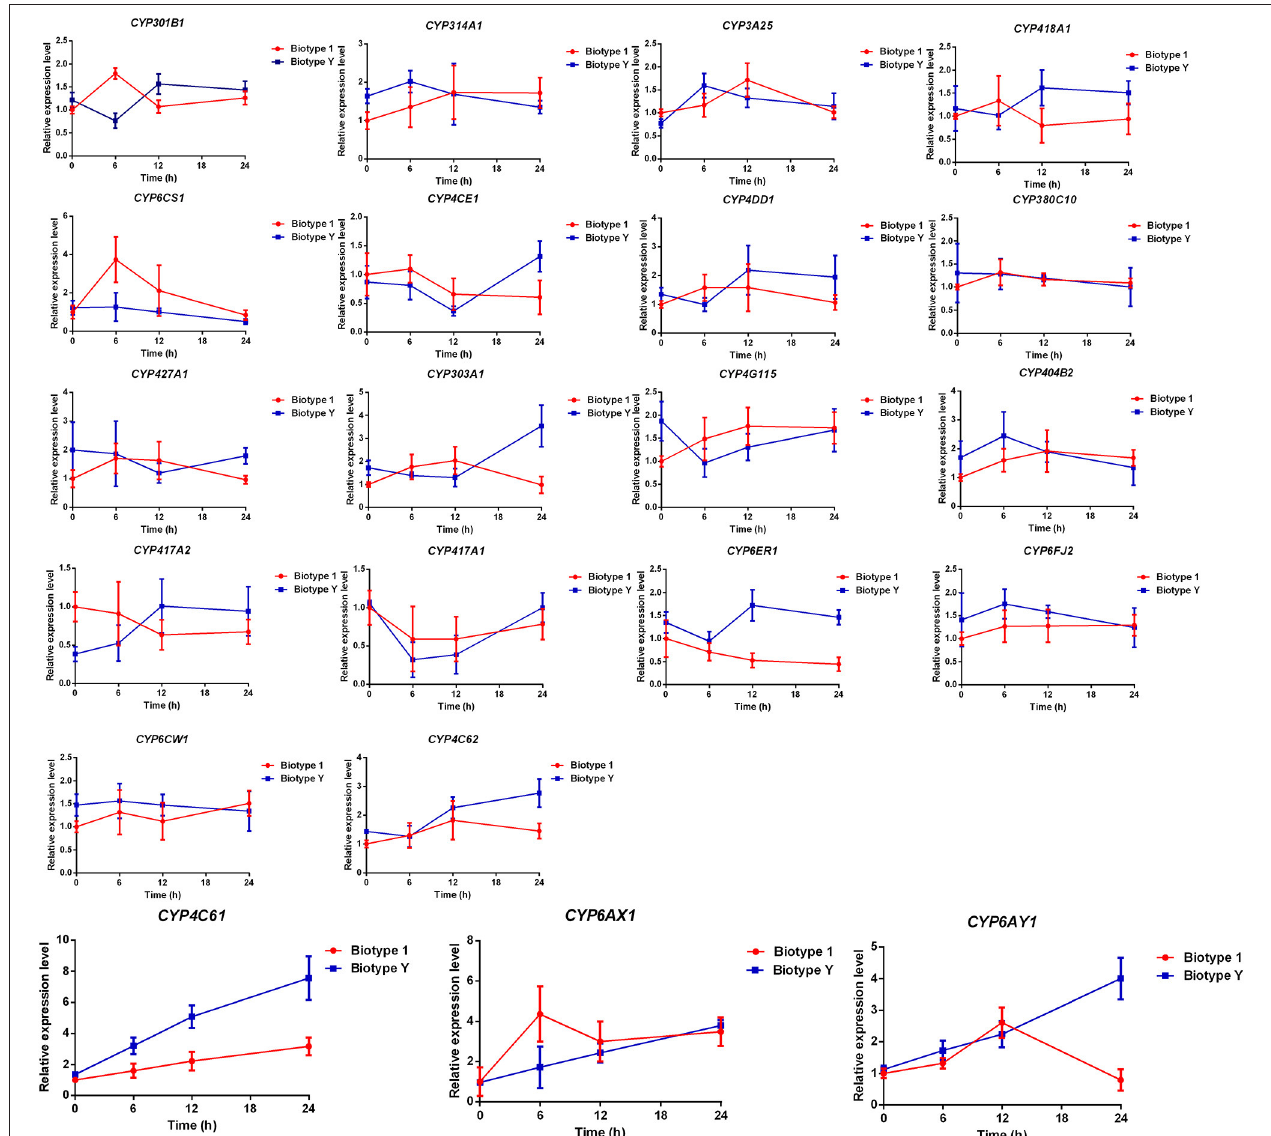
FIGURE 3 | qRT-PCR analysis of P450 mRNA levels. Time course of P450 enzyme expression in 5th instar nymphs of biotype 1 and biotype Y BPHs feeding on YHY15. Error bars represent means ± SEM. Essentially identical results were obtained in three independent experiments.